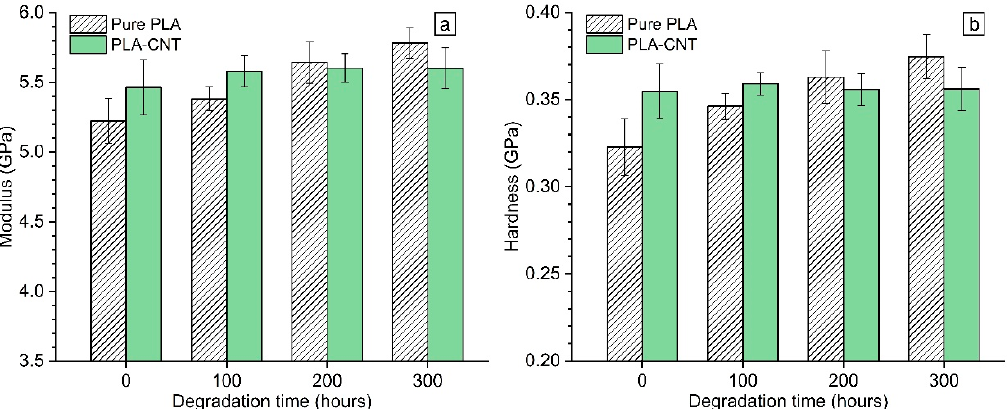
Figure 10. Evolution of ( a ) elastic modulus and ( b ) hardness of PLA and PLA-CNT during accelerated weathering degradation for up to 300 h.